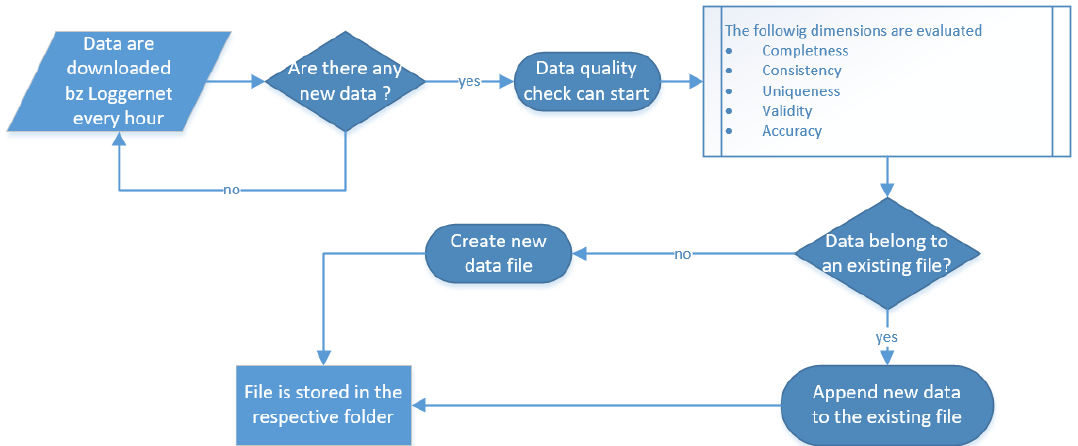
Figure 3. Flowchart describing the data quality-check performed to harmonize the collected